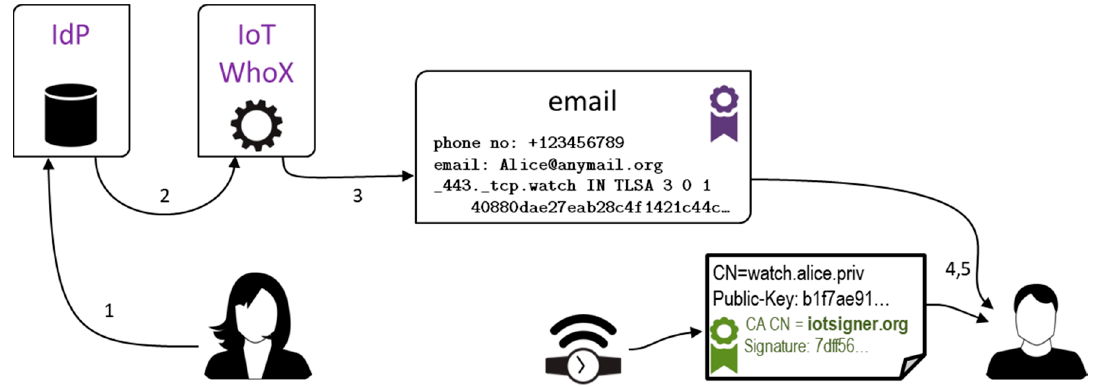
Figure 7. Selective communication of personal information.